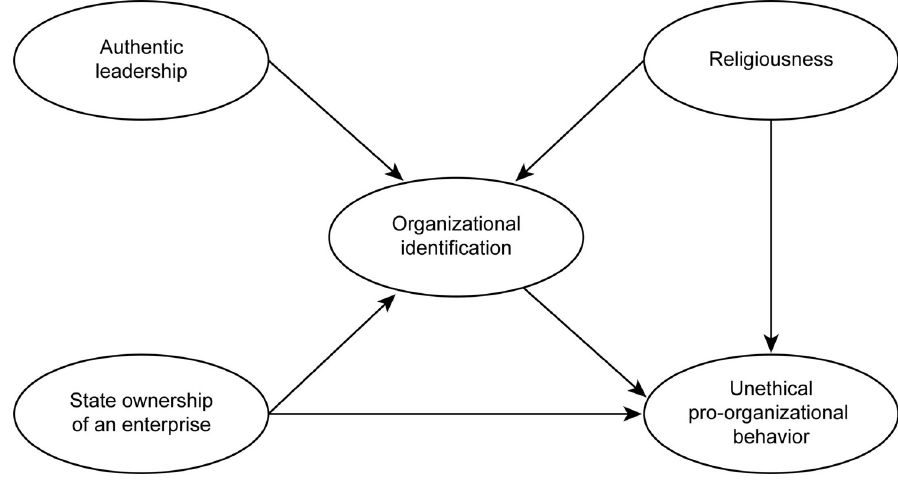
Fig 1. Proposed theoretical